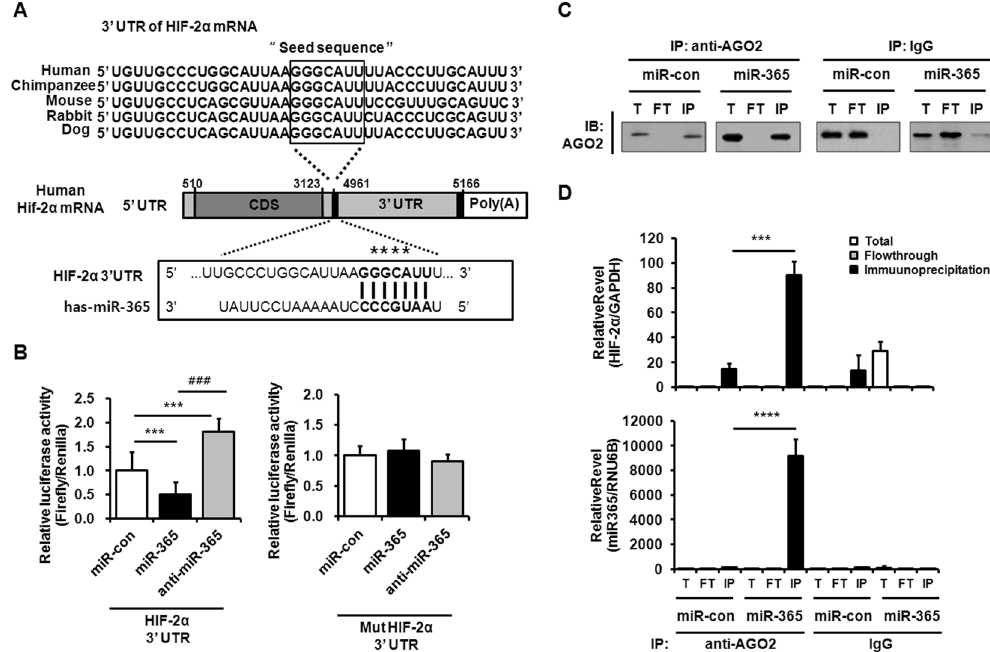
Figure 4. HIF-2 α mRNA is a target of miR-365. ( A ) Sequence alignment of a putative miR-365 binding site within the 3 ′ UTR of HIF-2 α mRNA from human, chimpanzee, mouse, rabbit, and dog. Asterisks indicate the sequences that were changed to make mutant HIF-2 α 3 ′ UTR. CDS, coding sequence; UTR, untranslated region. ( B ) The wild-type and mutant HIF-2 α 3 ′ UTR reporter plasmid was co-transfected with miR-365, anti- miR-365 or nonspecific control microRNA (miR-con) into human chondrocytes for 48 h. Luciferase activity in each sample was determined and calculated as the ratio of reporter (firefly) to control (Renilla) activity. Data are expressed as the mean ± SD of triplicate data from more than three independent experiments. ns, not significant, *** P < 0.005 vs. miR-con-transfected cells; ### P < 0.005 vs. miR-365-transfected cells. ( C ) AGO2-immunoprecipitation (IP) in miR-con- or miR-365-transfected chondrocytes. Primary chondrocytes were transfected with miR-con and miR-365 and stimulated with IL-1 β (1 ng/mL) for 6 h. The level of miR-365 expression was quantified by qRT-PCR. The efficiency of the AGO2-IP in total (T), flowthrough (FT), and immunoprecipitation (IP) fractions of the samples was determined by western blot analysis using AGO2 antibody. IP with IgG served as a negative control. ( D ) The levels of miR-365 and HIF-2 α mRNA in RNA samples from T, FT, and IP fractions of AGO2- and IgG-IP experiments were measured by qRT- PCR. *** P < 0.005 and **** P < 0.001 vs. miR-con-transfected